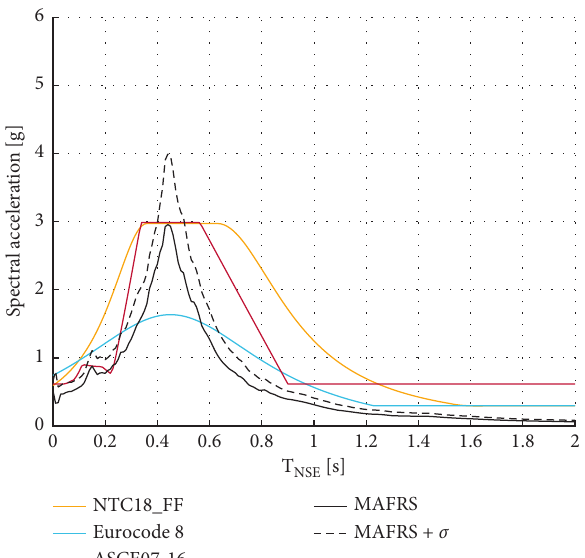
Figure 11: Comparison with Eurocode 8 [39] and ASCE07-16